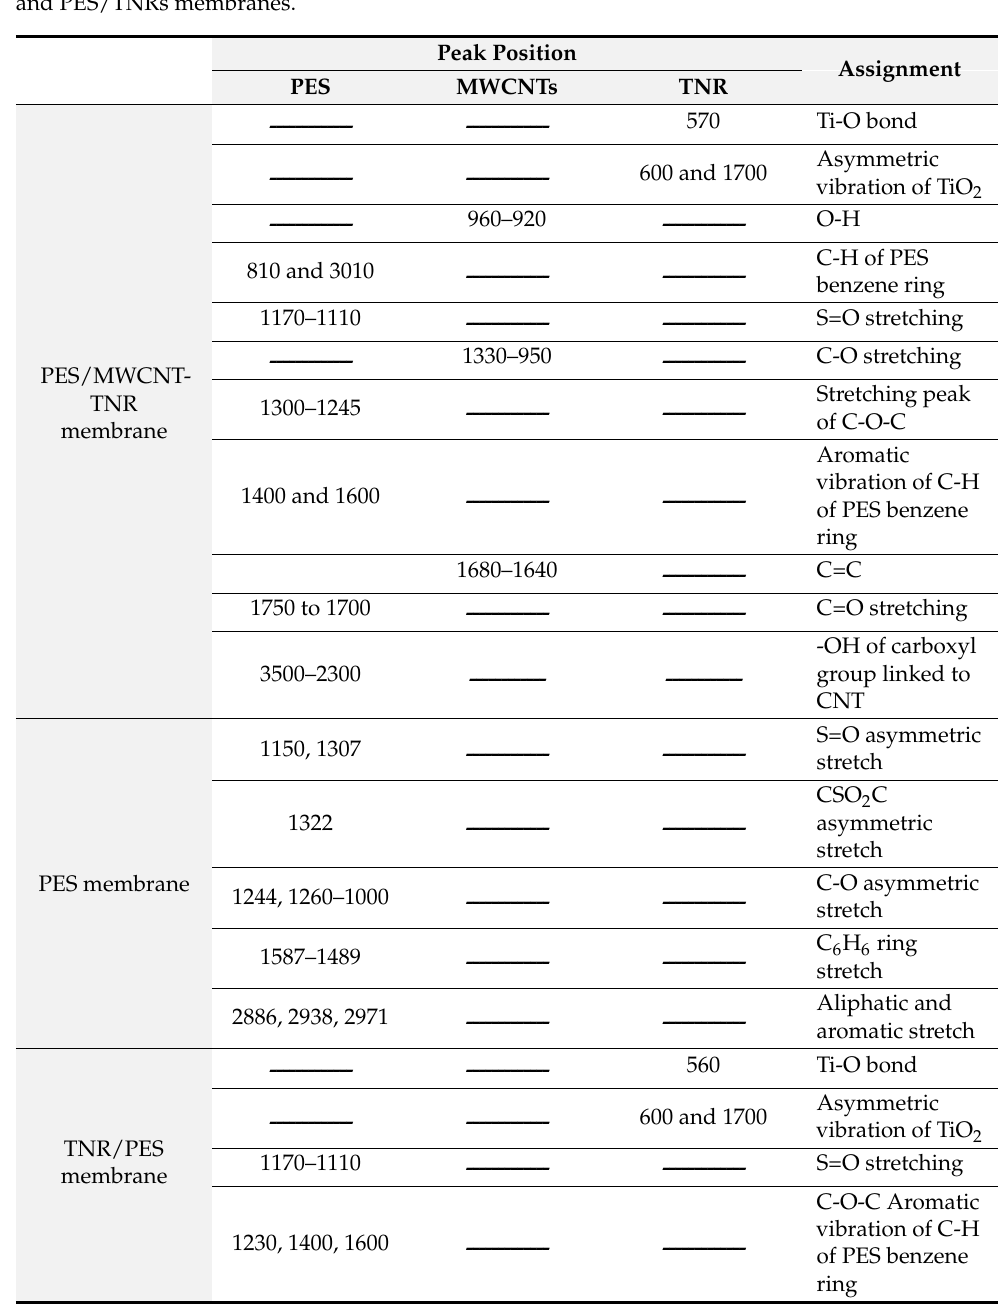
Table 1. FTIR spectral bands and the related functional groups of PES/TNR-MWCNTS, pure PES, and PES/TNRs